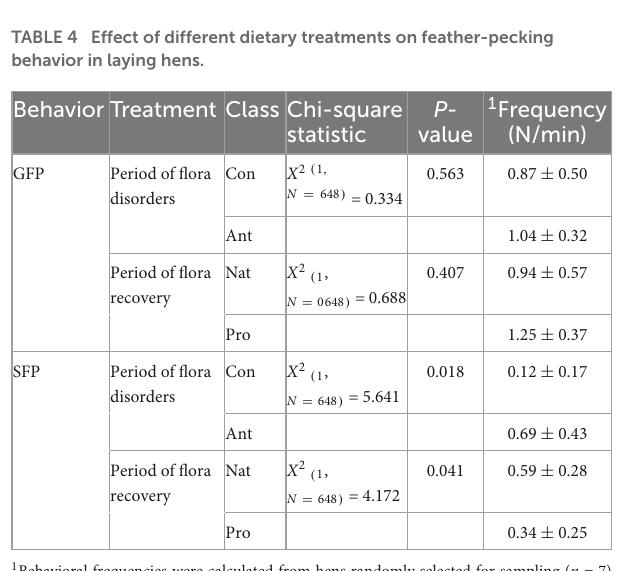
TABLE 3 Effect of different dietary treatments on the production performance of laying hens.